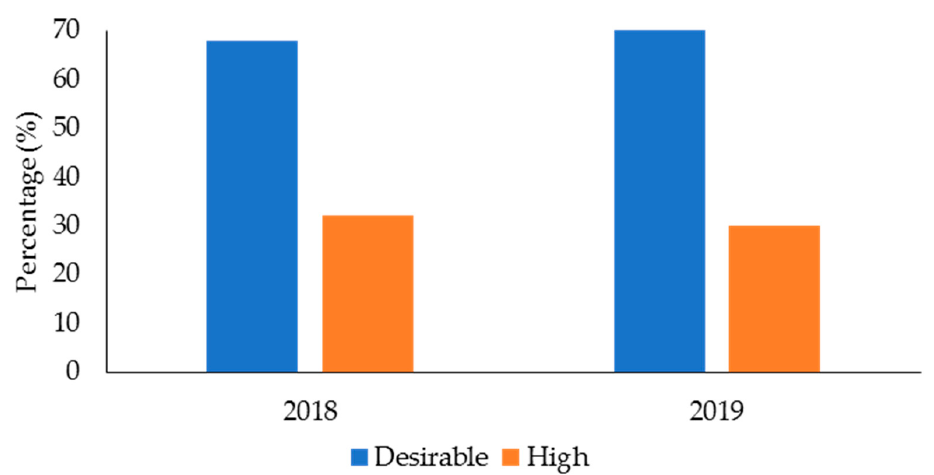
Figure 1. Percentage of police officers from a health and wellness program in 2018 and 2019 classified according to the categories for total cholesterol.